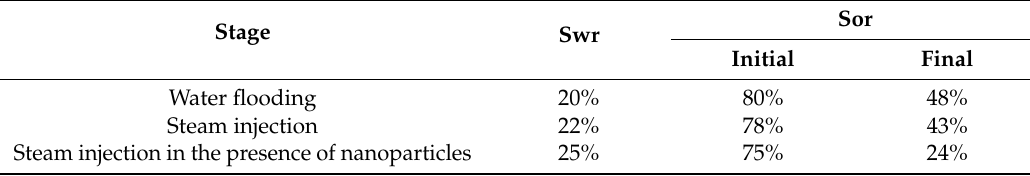
Figure 1. Oil recovery curves for cold water equivalent steam injection in the absence and presence of a nanofluid containing 500 mg/L of SiNi1Pd1 nanoparticles. Injection pressure and temperature were maintained at 8.96 MPa (1300 psi) and 300 ◦ C, respectively. Table 1. Estimated values for residual water saturation (Swr) and residual saturation (Sor) at different stages of the displacement tests. Injection pressure and temperature were maintained at 8.96 MPa (1300 psi) and 300 ◦ C,